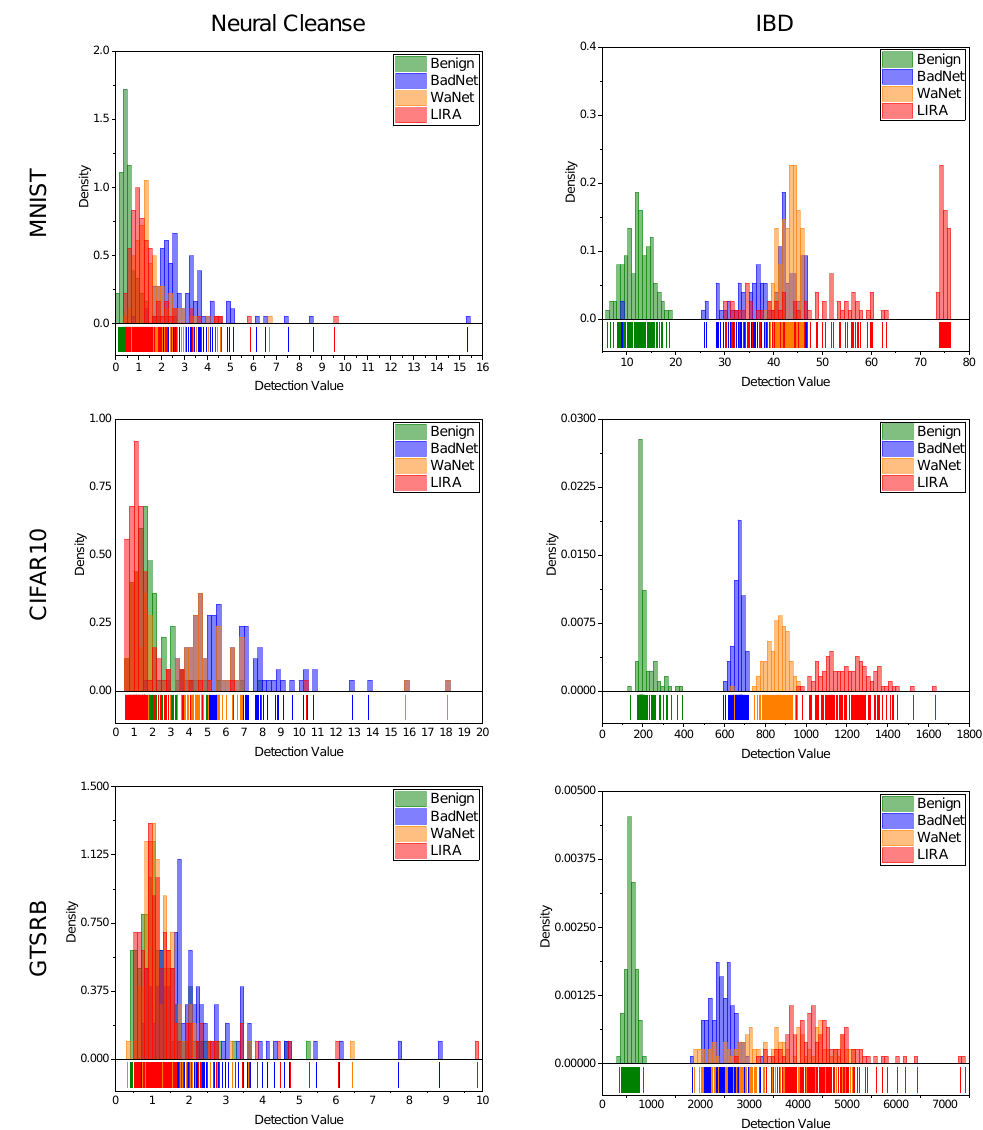
Figure 6. Histogram with RUG of IBD and Neural Cleanse when dealing with models trained on three different datasets. For each experiment, the test set contains 100 benign models and 3 × 100 poisoned models attacked by BadNet, WaNet, and LIRA,